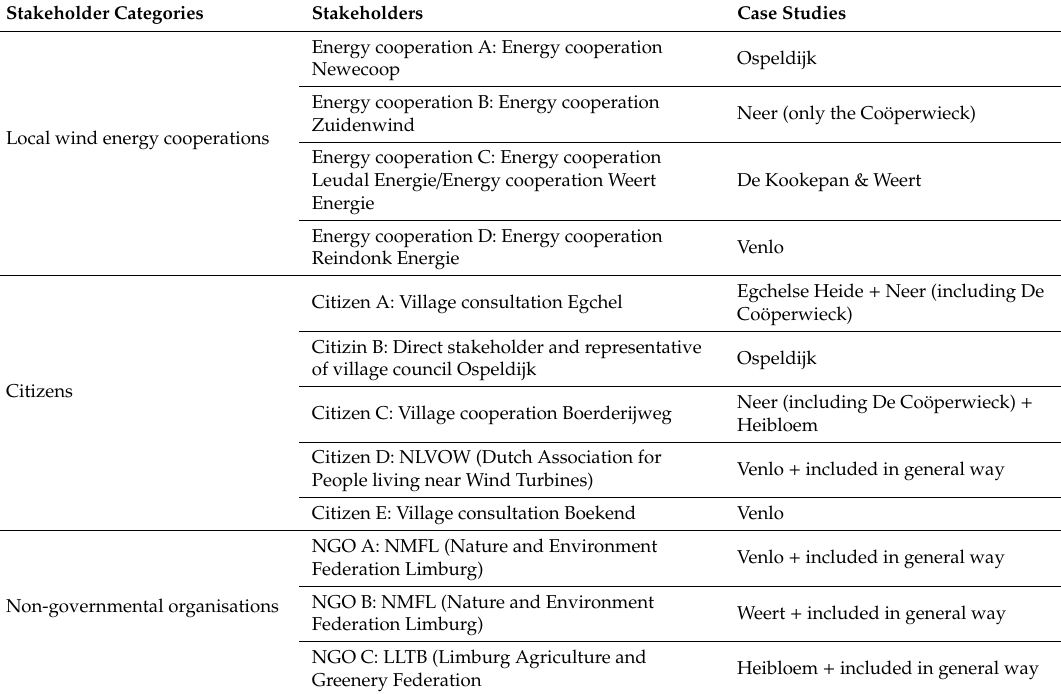
Table 4. Categorisation of